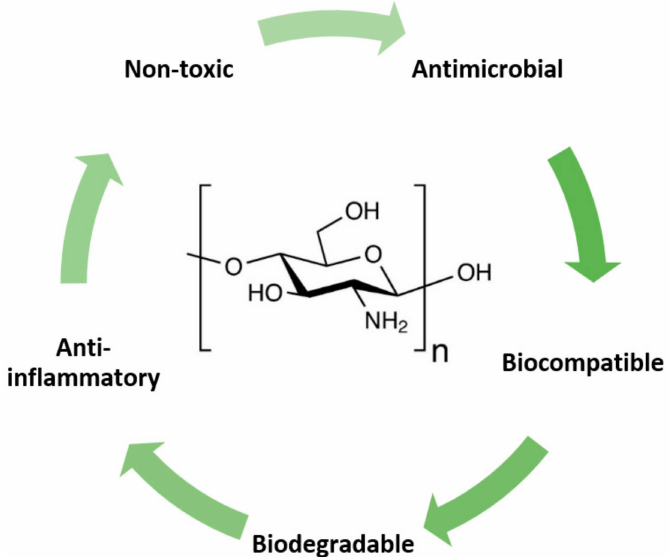
Figure 1. Unique biological properties allow the use of chitosan in many biomedical